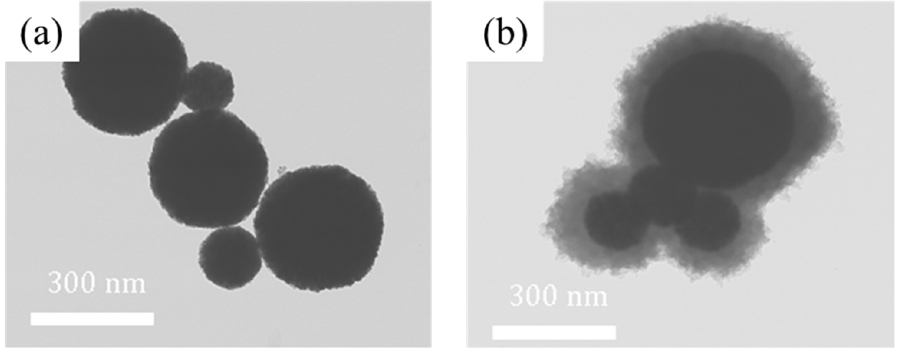
Figure 3. TEM photos of ( a ) the Fe 3 O 4 particles and ( b ) the Fe 3 O 4 /POA composite particles.